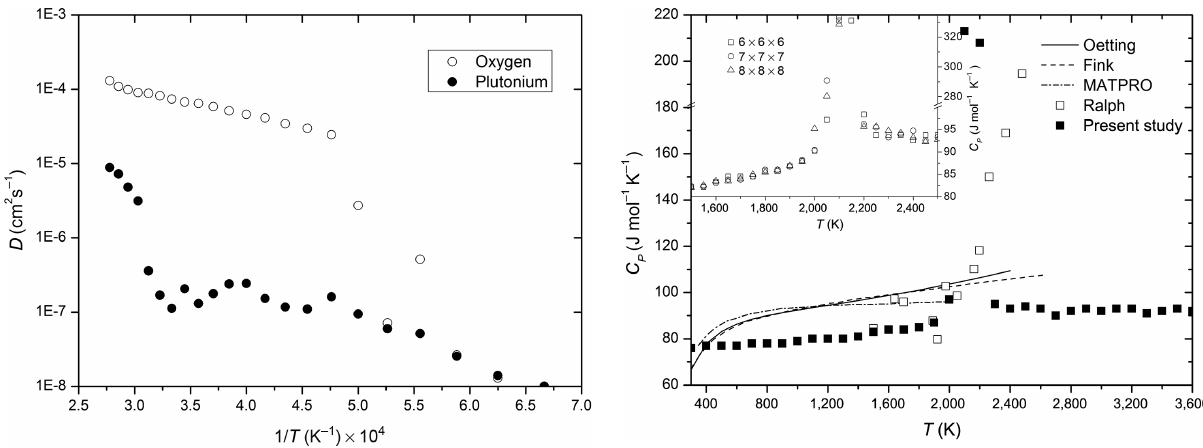
Figure 7: Temperature dependence of heat capacity for PuO 2 for the present study at 100 K intervals and comparison with experimental data. The inset shows the results for the different box sizes at 50 K